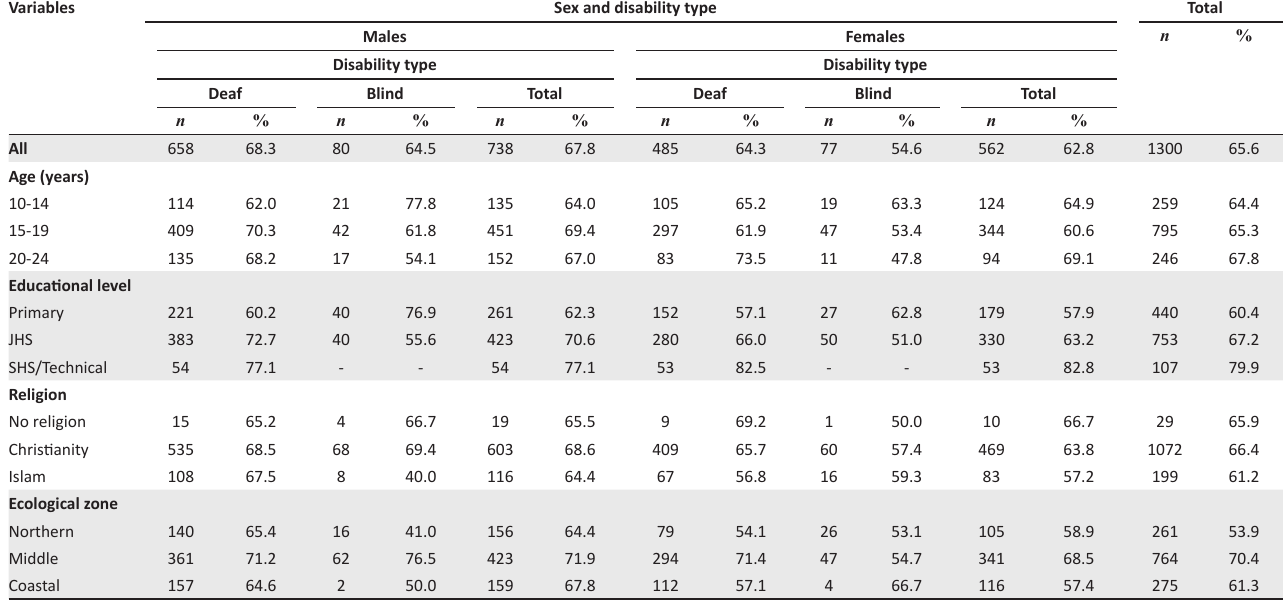
TABLE 3: Utilisation of sexual and reproductive health services by disability type and socio-demographic characteristics of respondents. Variables